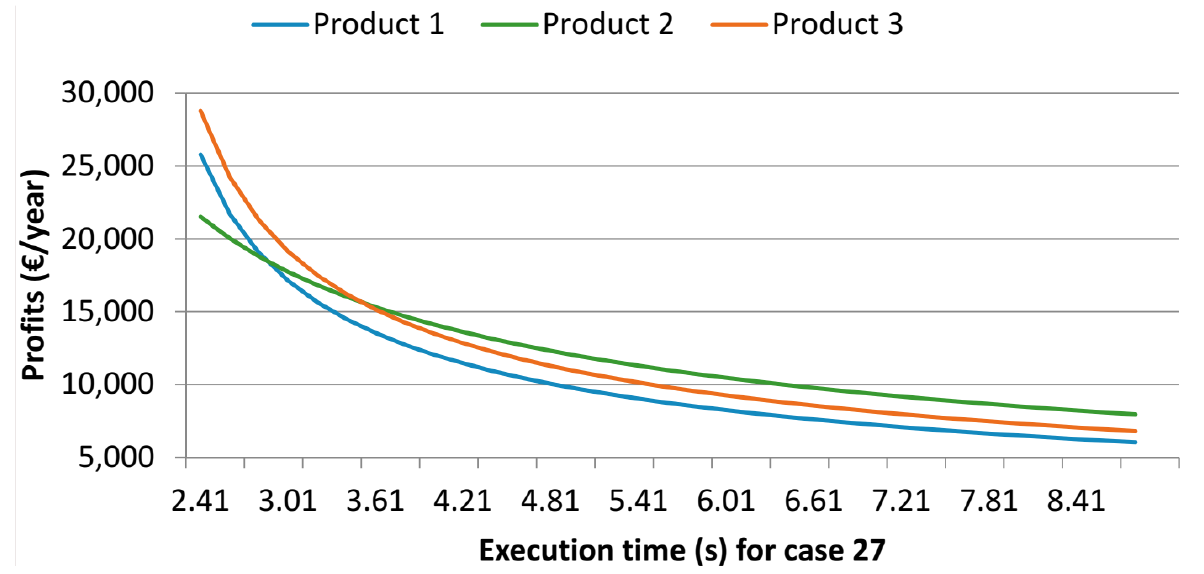
Figure 2. Pareto frontiers obtained with the optimization algorithm for case 27 for the three different products